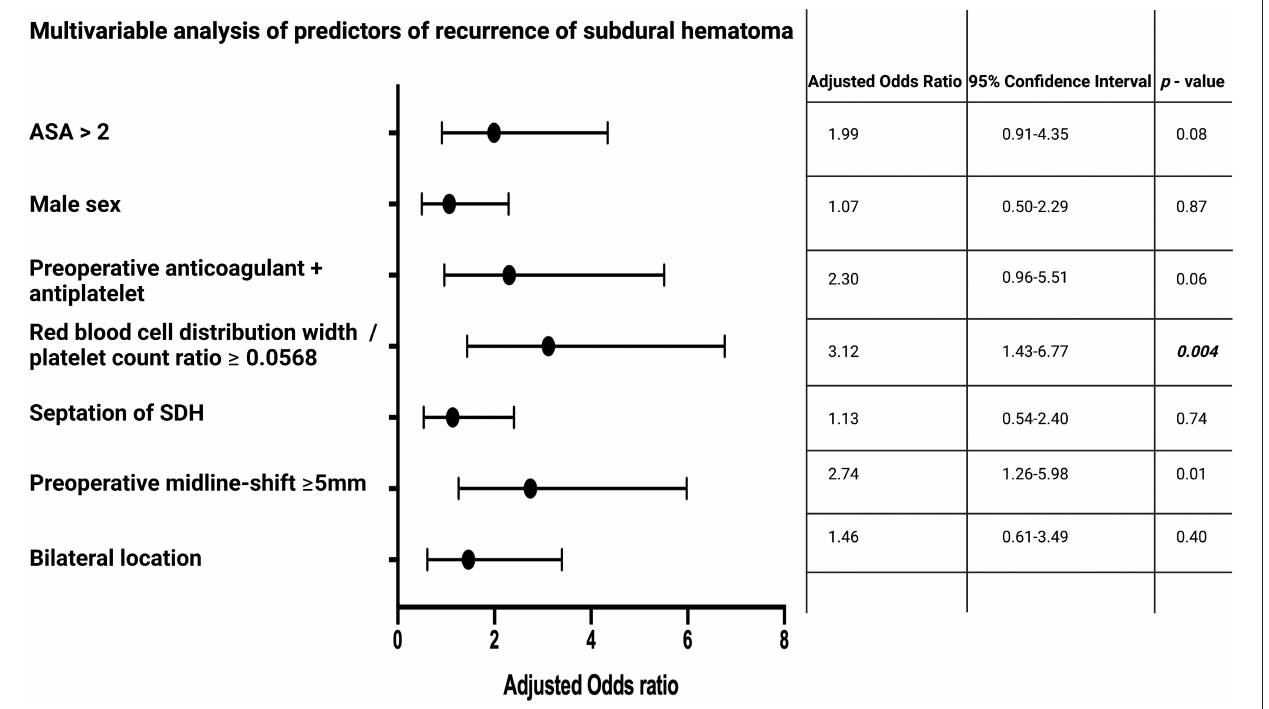
FIGURE 2 | Forest plots from multivariable logistic regression analysis: High red blood cell distribution width to platelet count ratio ( ≥ 0.0568), and a preoperative midline-shift ≥ 5mm are independent predictors of cSDH recurrence. p -Values in italics and bold display statistically significant results.